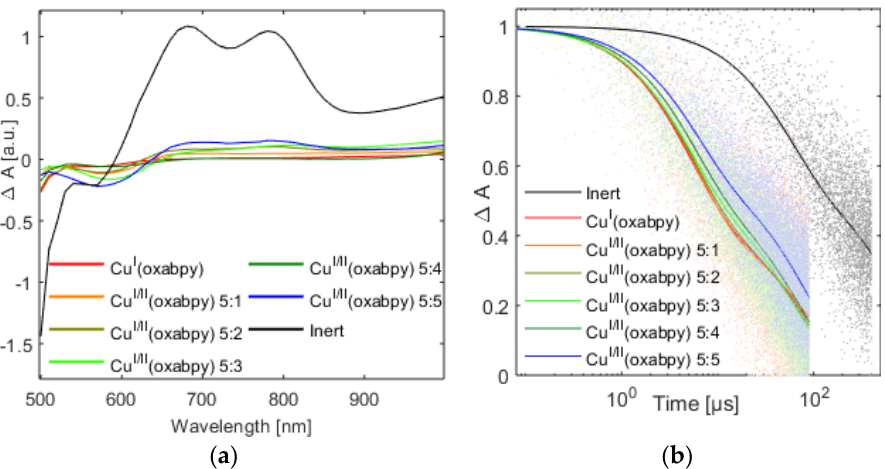
Figure 7. ( a ) Photoinduced absorption and ( b ) transient absorption spectra of Y123 ‐ sensitized photoanodes in inert (black) as well as Cu(oxabpy) electrolyte. The color code indicates the ratio of Cu II in the Cu(oxabpy) electrolyte (orange = standard electrolyte 0.2 M Cu I , 0.04 M Cu II ; blue = 1:1 mixture).